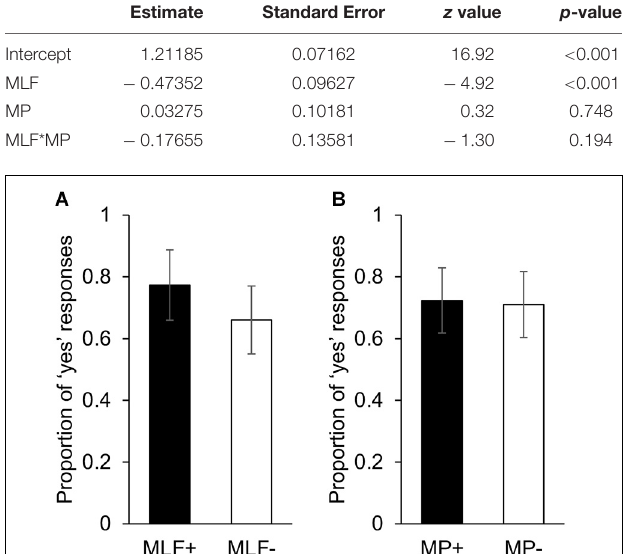
TABLE 6 | Fixed effect estimates derived from the binomial logistic regression on subjective responses data. Estimate